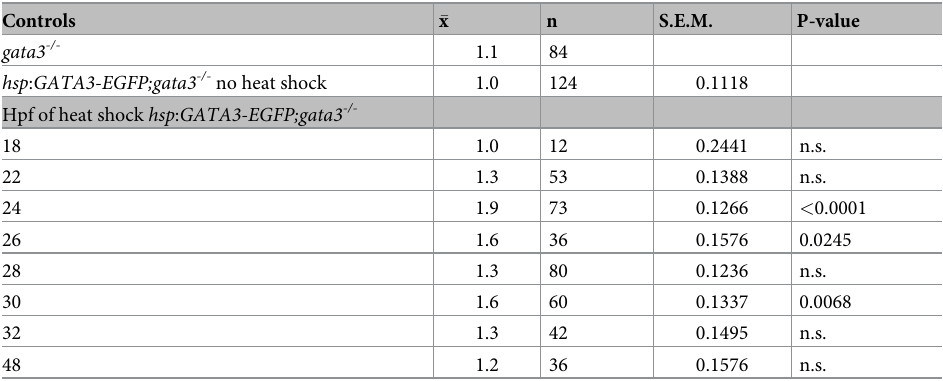
Table 2. gata3 rescue statistics.